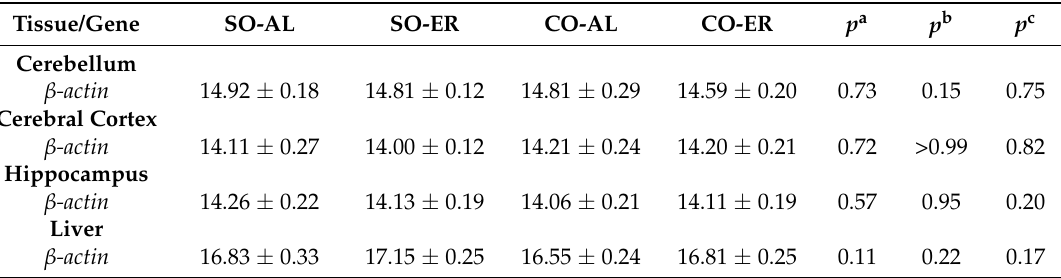
Table A5. qPCR Ct values for β -actin